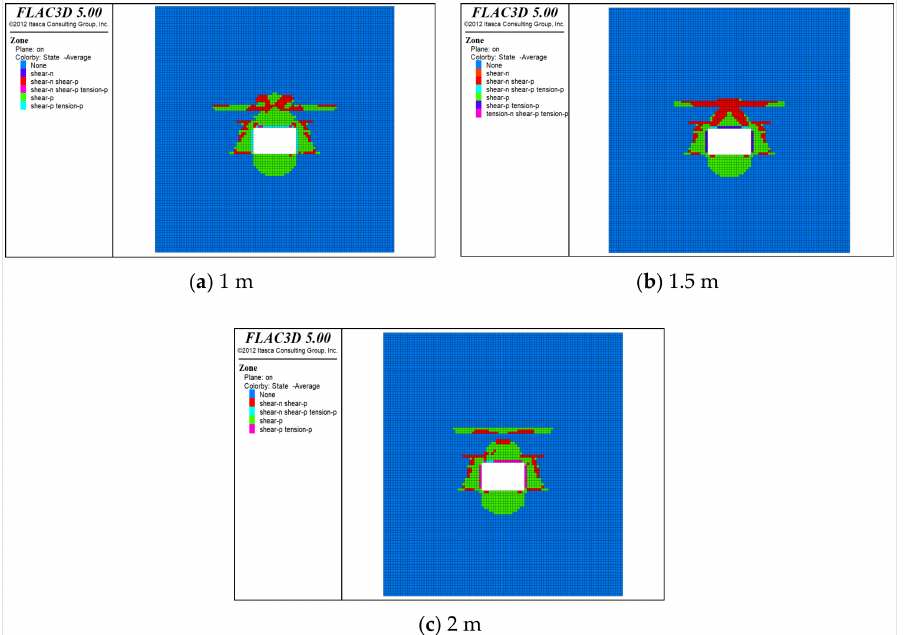
Figure 8. Distribution map of plastic zones surrounding rock in roadways of hard rock layers of different thicknesses.